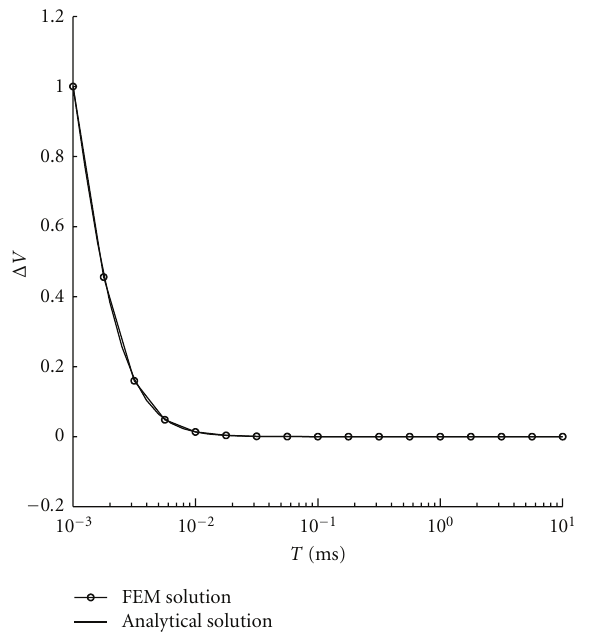
Figure 3: Horizontal tabular orebody